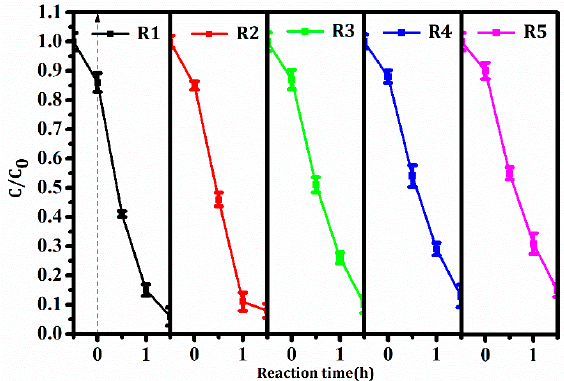
Figure 10. Cycling test of BiVO 4 /Mn 1 − x Zn x Fe 2 O 4 /RGO in RhB photodegradation (five recycles). Figure 11 was FTIR spectra of the compounds. The peaks at 473.7 cm − 1 and 412.4 cm − 1 in Figure